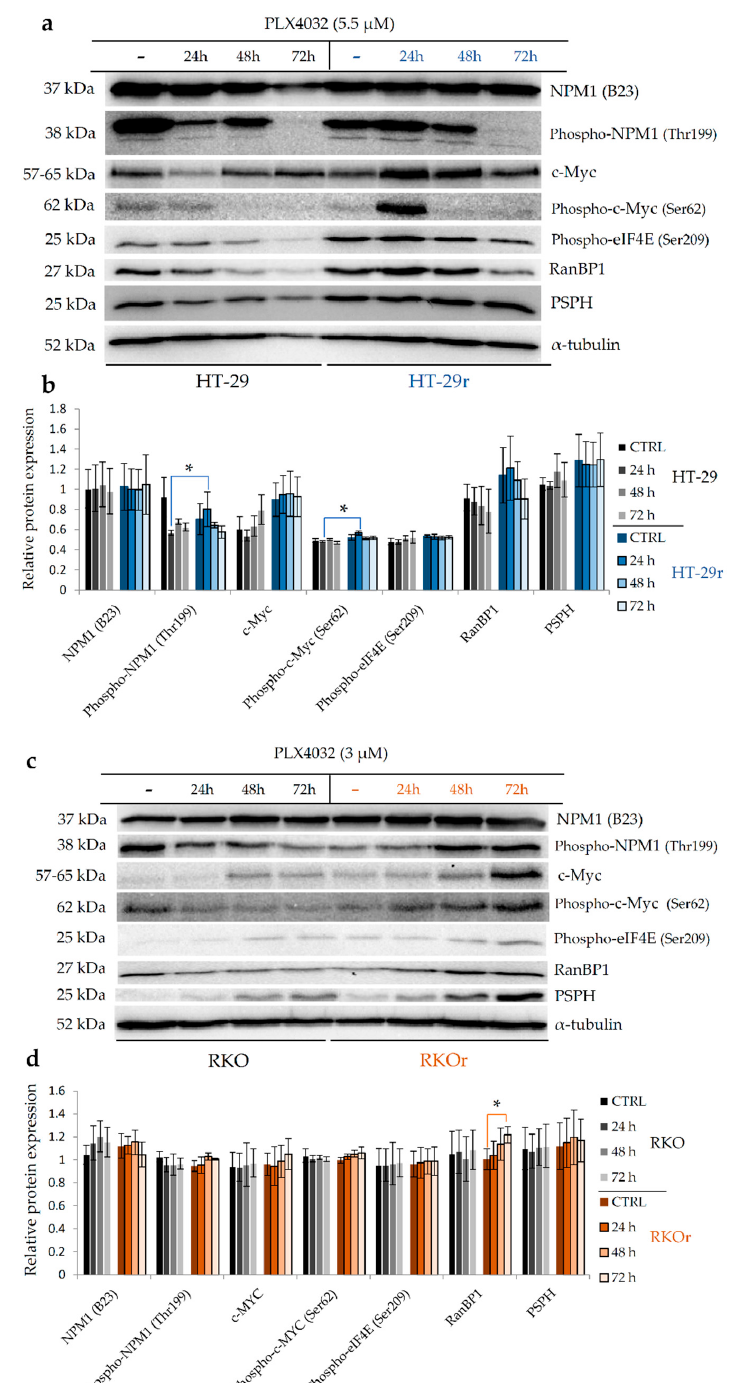
Figure 5. Western blot analysis of relative expression of selected proteins in BRAFV600E-mutated HT-29 ( a , b ) and RKO ( c , d ) sensitive and vemurafenib (PLX4032)-resistant colon cancer cell lines